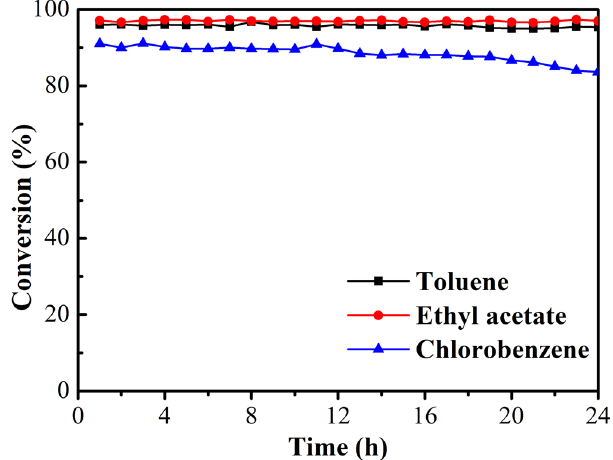
Figure 3. Stability tests of R-Ag/MnO 2 -cordierite for toluene, ethyl acetate and chlorobenzene; reaction conditions: temperature = 280 °C for toluene, 230 °C for ethyl acetate, 390 °C for chlorobenzene; VOCs = 1000 ppm; catalyst content = 0.1 g/cm 3 ; SV = 10,000 h − 1 .